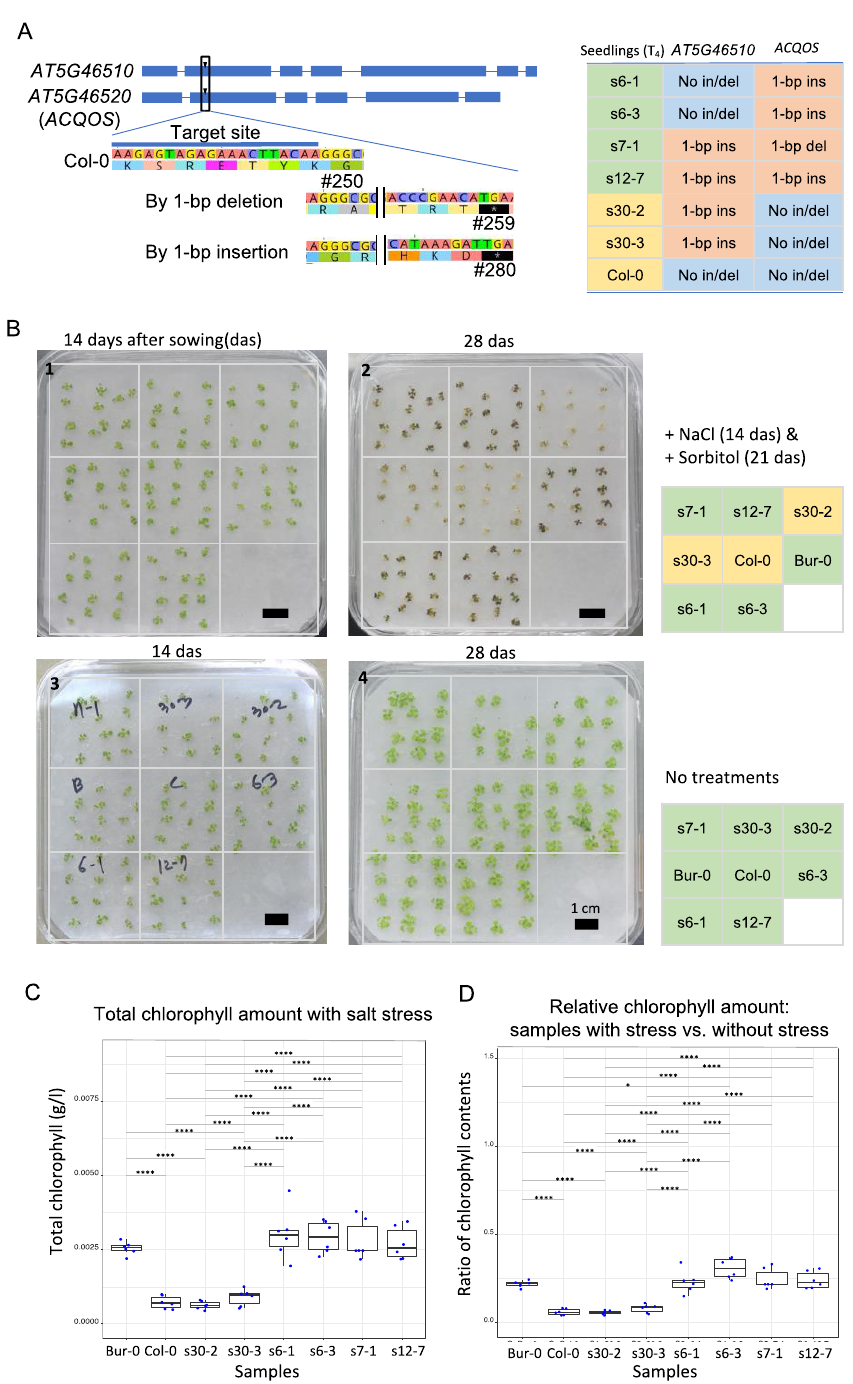
Figure 2. Salt stress resistance was determined in T 4 transgenic plants by measuring chlorophyll content. ( A ) An illustration showing the mutagenesis target locations in AT5G46510 and AT5G46520: ACQOS , as well as the predicted early stop codon positions for 1 bp deletion (top) or insertion (bottom) mutations. Table (right) showing the mutant alleles examined in the T 4 transgenic lines. ( B ) Representative images of a batch of T 4 seedlings. Seedlings (12 × 8 samples) of each genotype were arranged on filter paper within the culture plate and treated with sodium chloride (NaCl) at 14 days after sowing (das), then with sorbitol at 21 das (B1 and B2). Culture plates containing untreated control plants are shown for comparison (B3 and B4). Black bars are 1 cm scale bar. ( C )